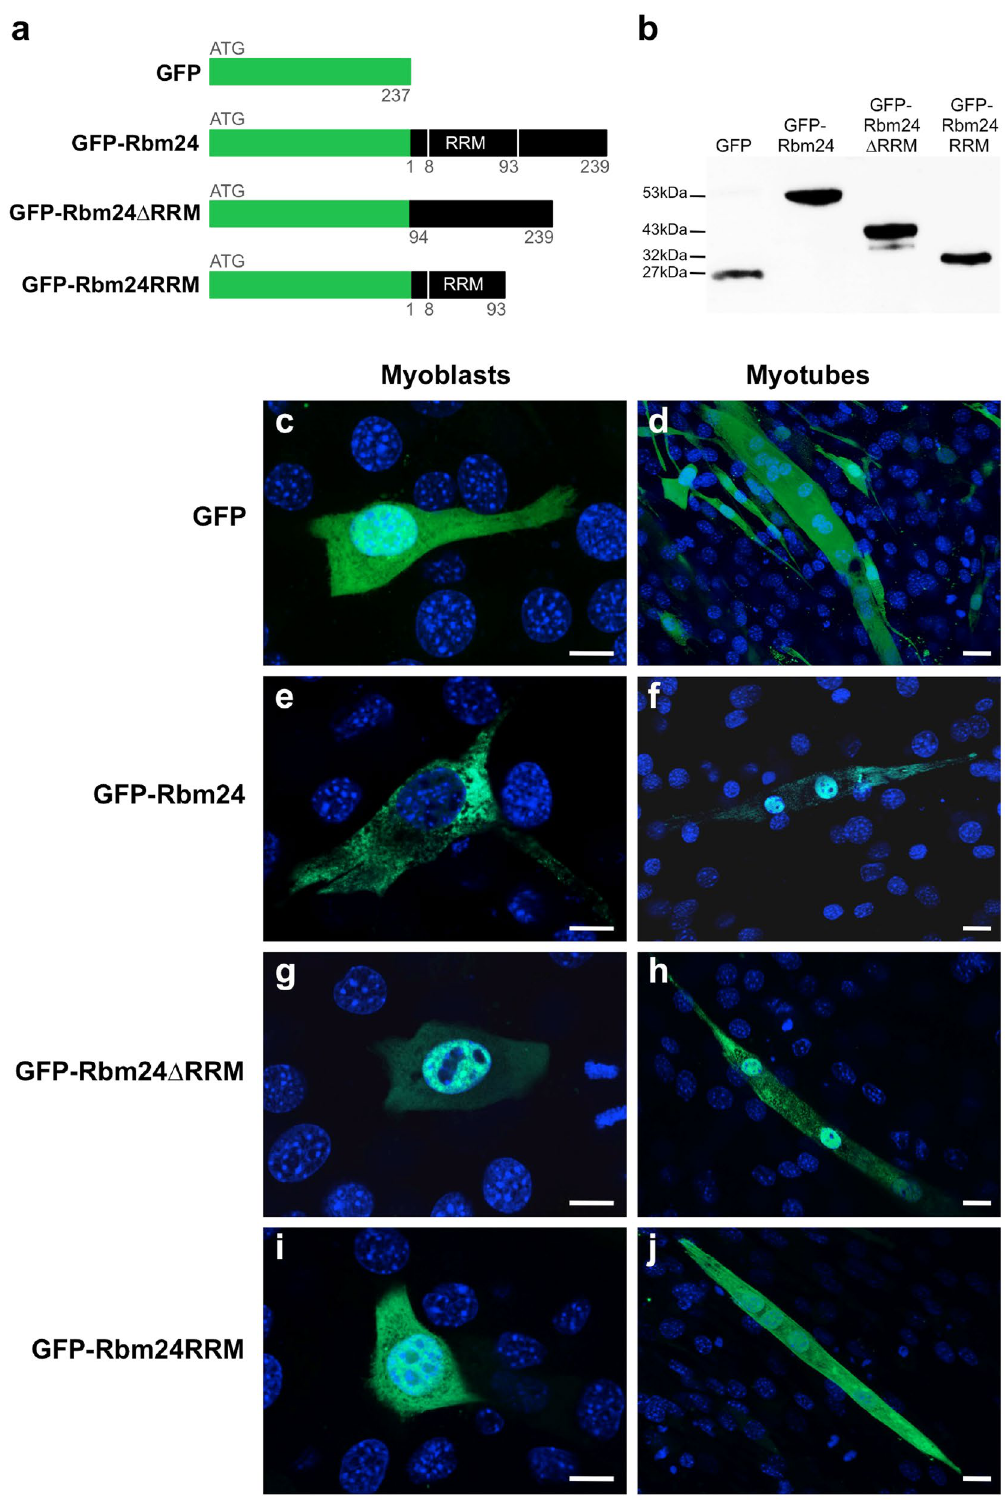
Figure 2. Cytoplasm to nucleus translocation of Rbm24 during myogenic differentiation in C2C12 cells. ( a ) Schematic representation of GFP-tagged full-length and truncated forms of Rbm24 proteins. Numbers indicate amino acid residues in mouse Rbm24 protein. ( b ) Western blot analysis of indicated fusion proteins in C2C12 myoblasts 24 h after transfection using a GFP antibody. Full-length blot is presented in Supplementary Fig. S1. ( c – j ) Subcellular localization of different fusion proteins after transient transfection in C2C12 cells, which were counterstained with DAPI. ( c , d ) GFP alone was uniformly distributed in proliferating myoblasts 24 h after transfection and in multinucleated myotubes after 3 days of differentiation. ( e , f ) GFP-Rbm24 was heterogeneously distributed in the cytoplasm of myoblasts, but was predominantly localized in the nucleus of differentiated myotubes. ( g , h ) GFP-Rbm24ΔRRM was mainly localized in the nucleus of myoblasts, and was distributed both in the cytoplasm and nucleus of differentiated myotubes. ( i , j ) GFP-Rbm24RRM was uniformly distributed in proliferating myoblasts and in multinucleated myotubes. Scale bars: 10